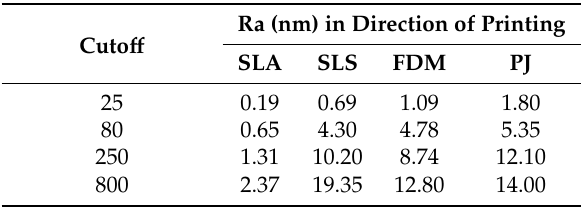
Table 3. Roughness average (Ra) measured in direction of printing. Cutoff